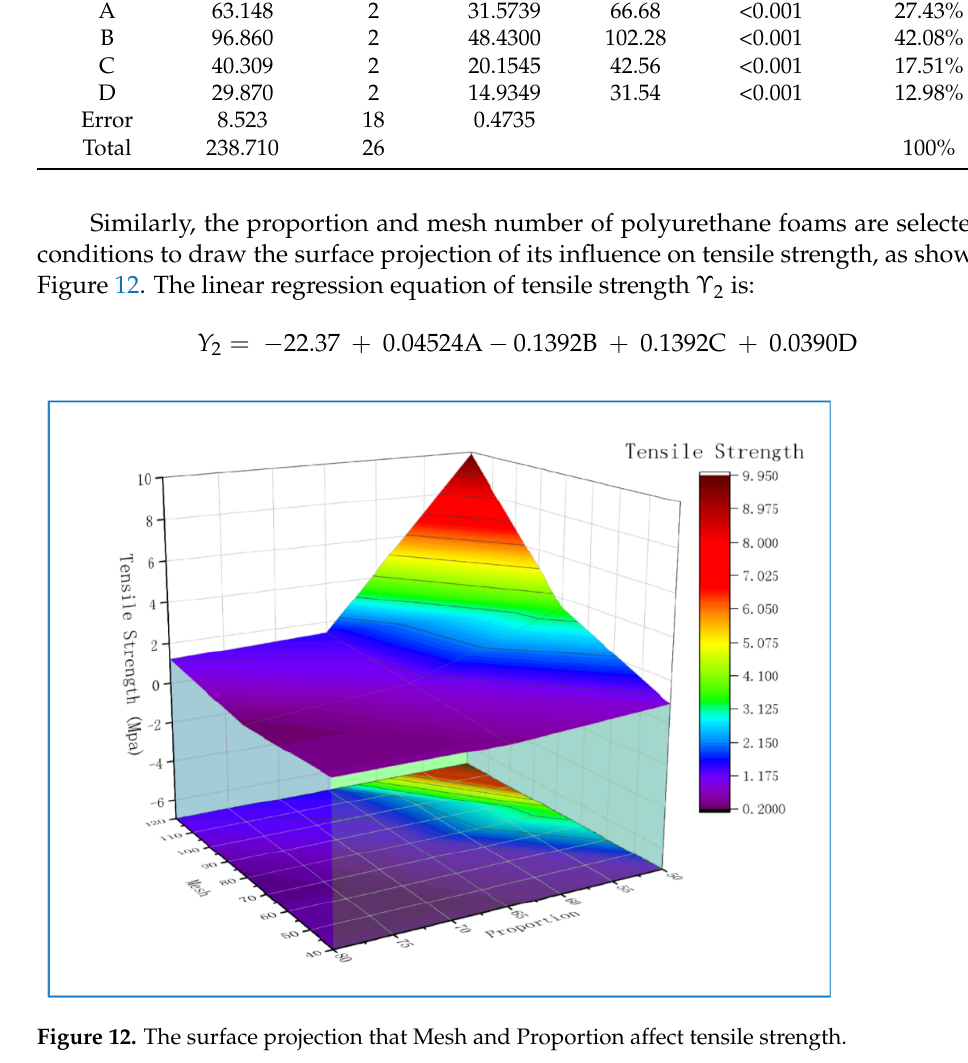
Figure 11. Stress versus strain curve (The numbers in the figure represent different experiment numbers).